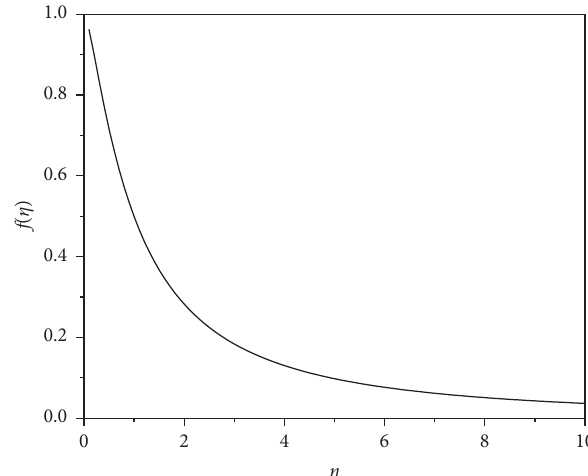
Figure 4: The relationship between f(η) and η ( η � r